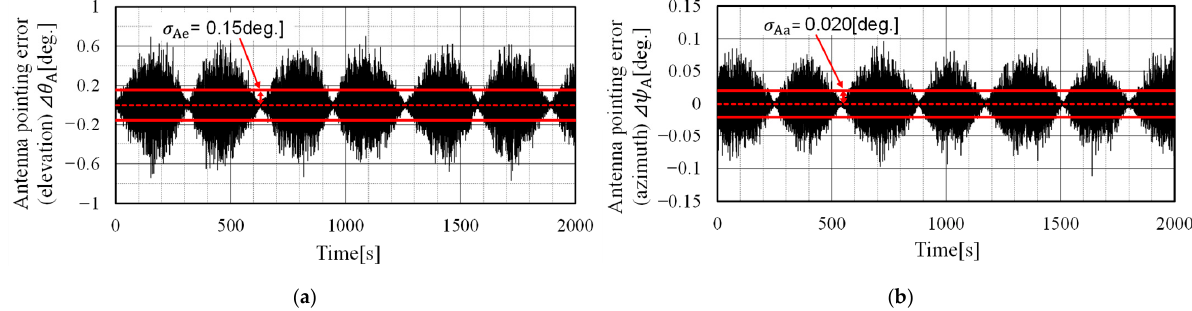
Figure 23. Time history of the antenna’s pointing control errors using RF sensor with 0.1 deg. accuracy directions. ( a ) Elevation. ( b ) Azimuth.